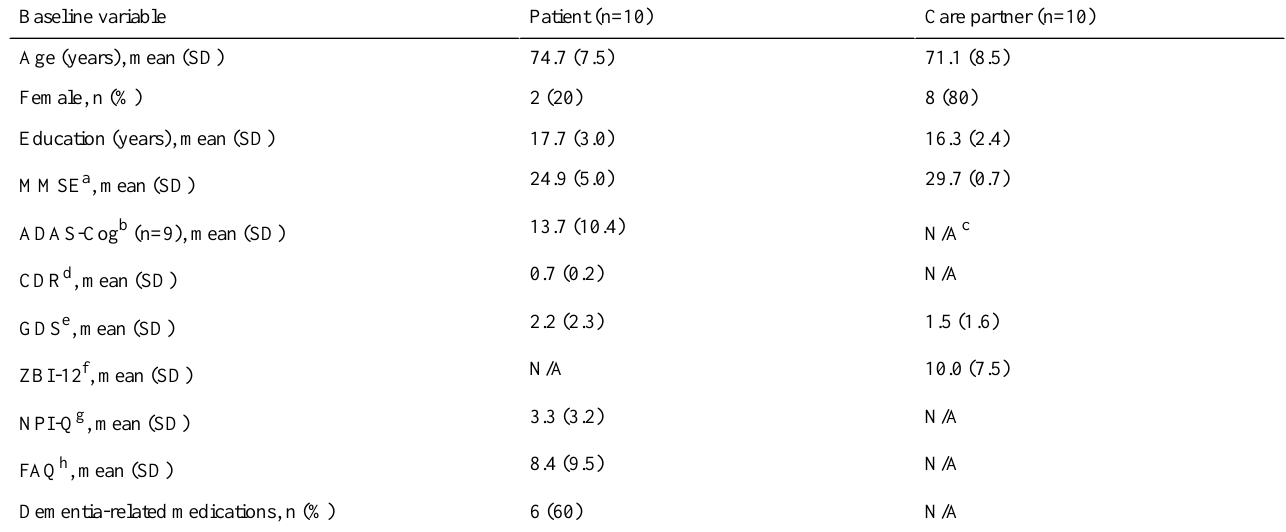
Table 3. Demographics for participants from 10 homes